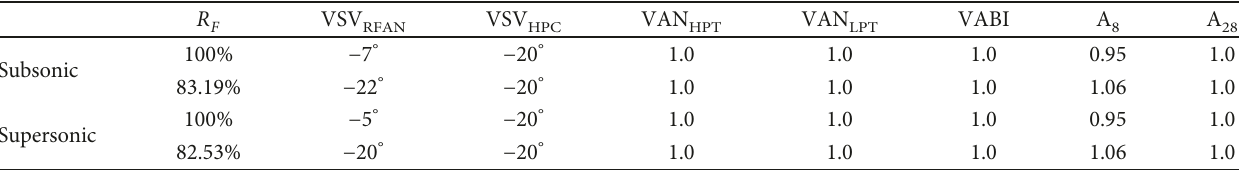
Table 4: Control schedule of variable geometries (group 1).